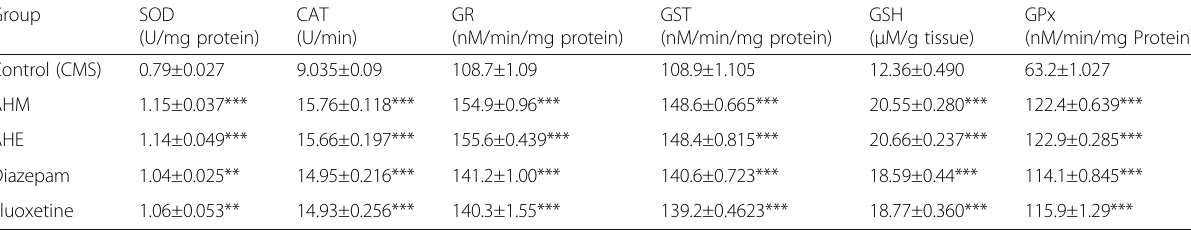
Table 4 Effect of oral dose of AHM and AHE for 7 days on brain antioxidant status Group